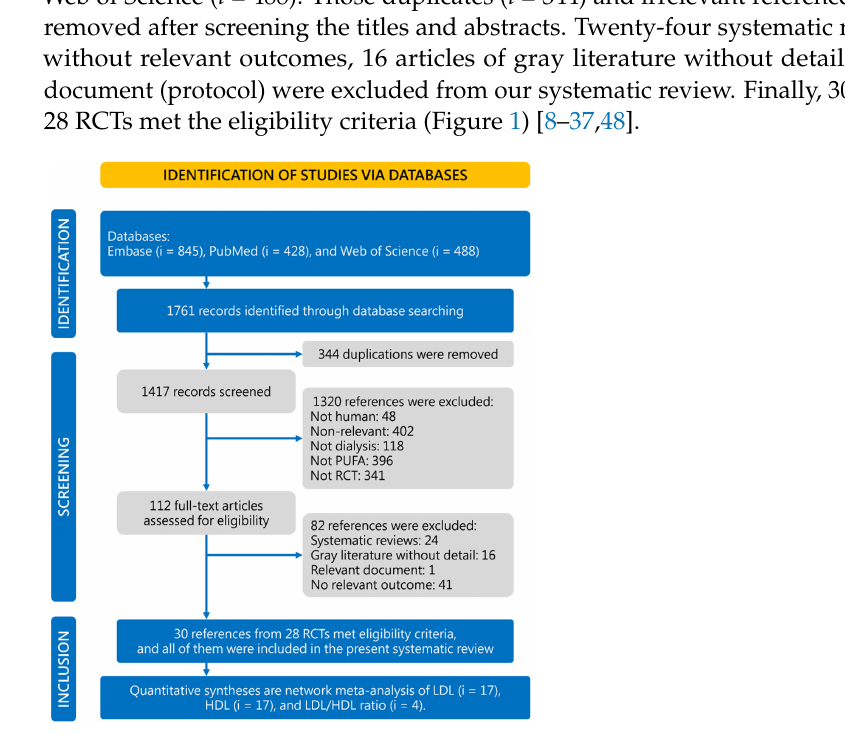
Figure 1. Flowchart of the systematic review and meta-analysis. HDL, high-density lipoprotein; LDL, low-density lipoprotein; PUFA, polyunsaturated fatty acid; RCT, randomized controlled trial. 3.1. Characteristics and Quality of the Included Studies The 28 RCTs recruited 2017 dialysis patients from Brazil [13,24], Canada [14], Den- mark [15,30,32,34–36], Egypt [10], Iran [9,16–19,21,22,25–29,37], Korea [8,23], Spain [48] and the United States [11,12,31]. These trials could be categorized into eight treatment strategies, including placebo, vitamin E and medium-chain triglycerides (MCTs), omega- 3 FAs, the combination of omega-3 FAs and vitamin E (n-3 + VitE), the combination of omega-6 FAs and vitamin E (n-6 + VitE), the combination of n-3 + n-6 and combination of n-3 + n-6 + VitE. Table 1 presents relevant information about the trial location, inclusion years, treatments, mean age, sex and dialysis period. File S2 presents the results of the quality assessment of the included trials. Table 1. Characteristics of the included randomized controlled trials. Lead Author Location Inclusion Year Treatments